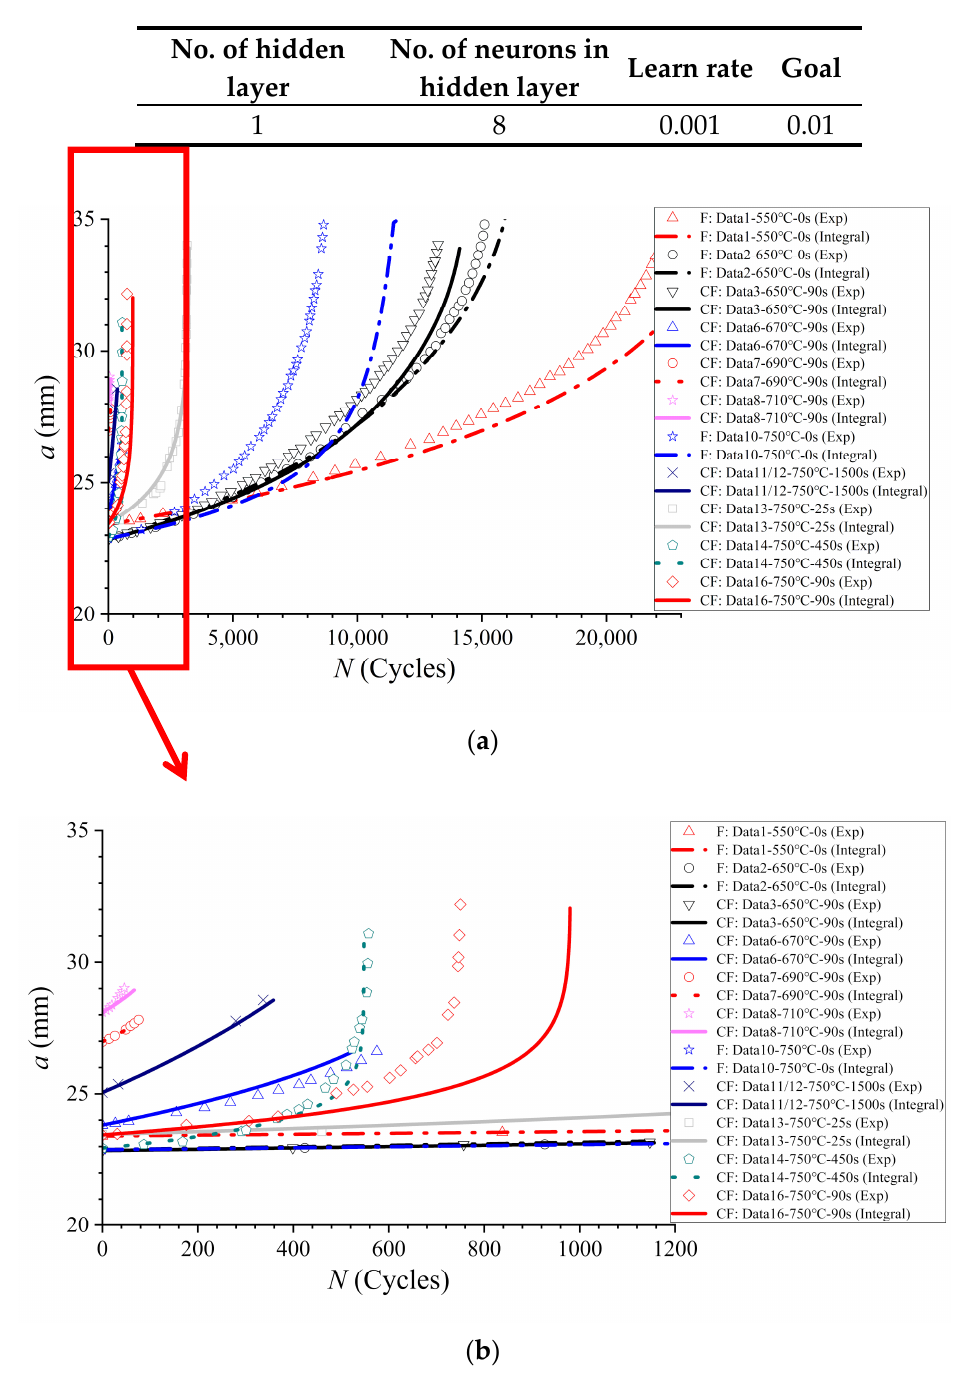
Figure 9. Prediction of a - N curves using NNK method for conditions with different elevated temperatures (650–750 °C) and different holding times (t hold from 0 to 1500 s).